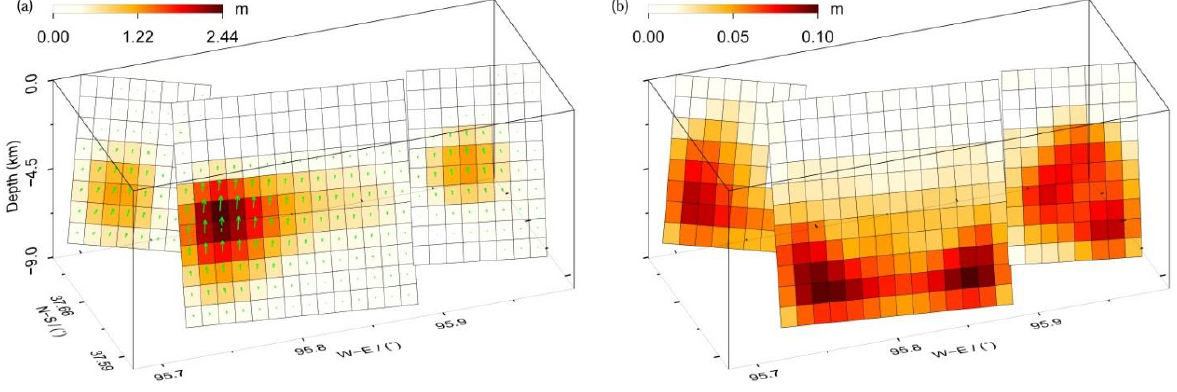
Figure 6. The preferred slip distribution ( a ) and its errors from Monte Carlo analysis ( b ). The green arrows in ( a ) denote the rake of each